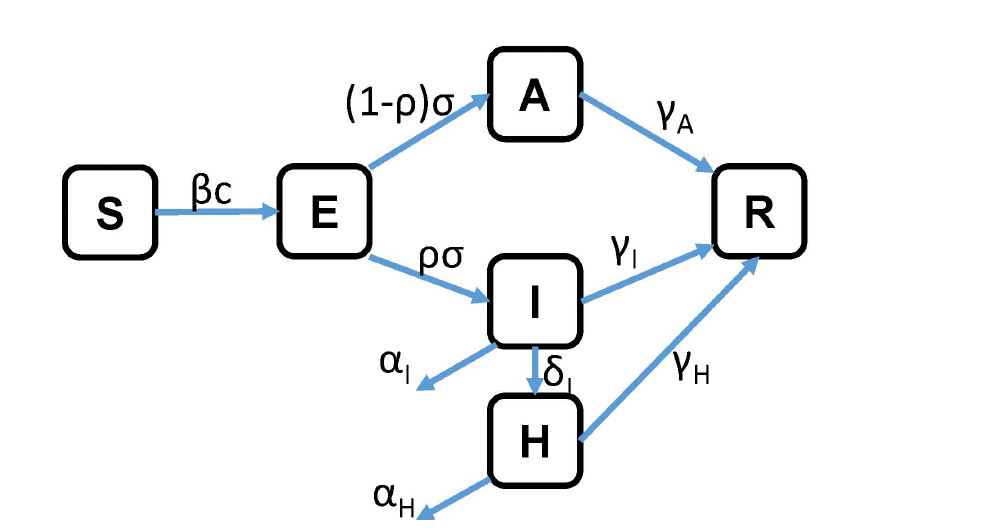
Fig. 1. Compartmental flow chart for